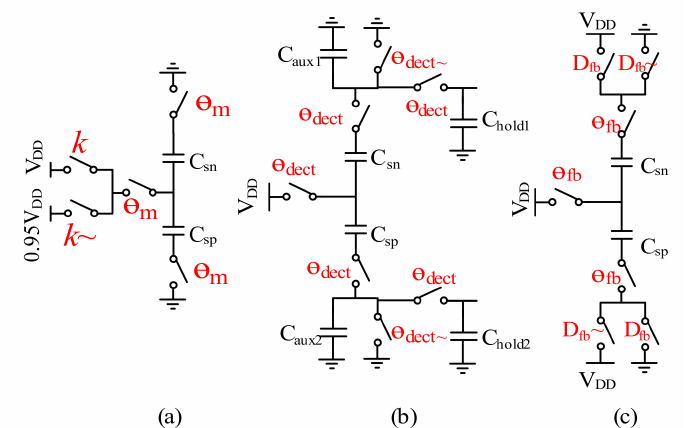
Figure 9. ( a ) Reset phase; ( b ) Signal detection phase; ( c ) Force feedback